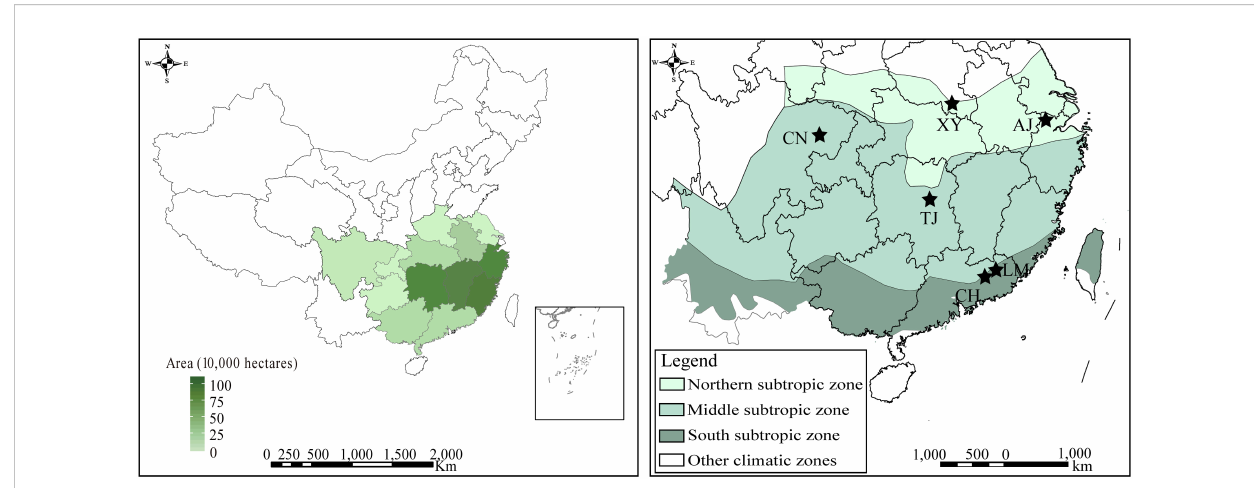
FIGURE 1 Distribution area and sampling site locations of moso